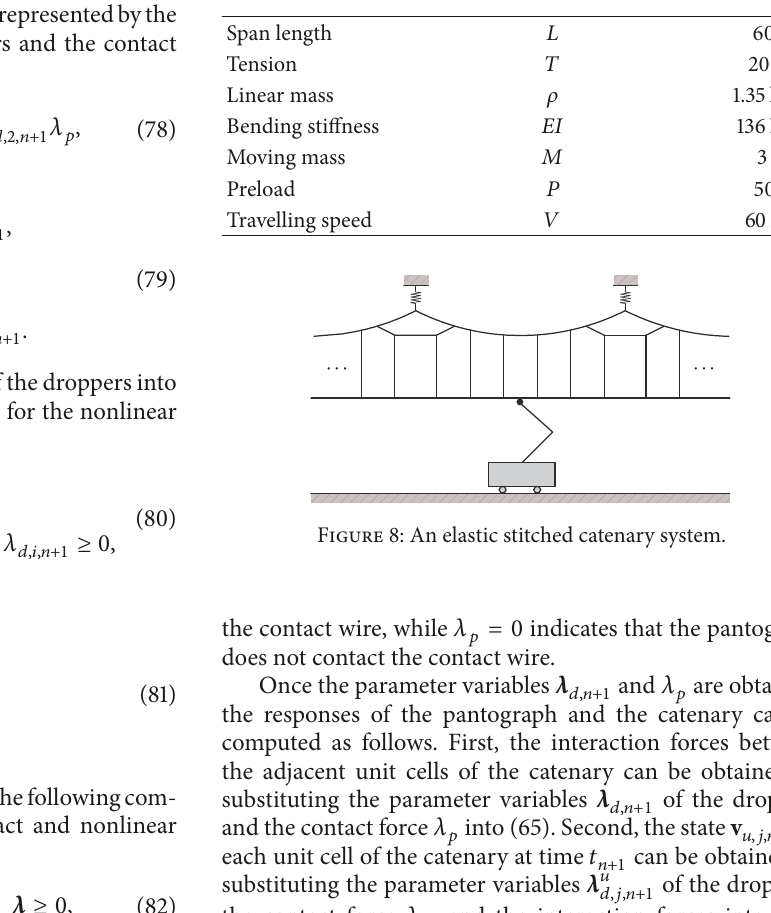
Table 1: Parameters of the beam and the moving mass [6].